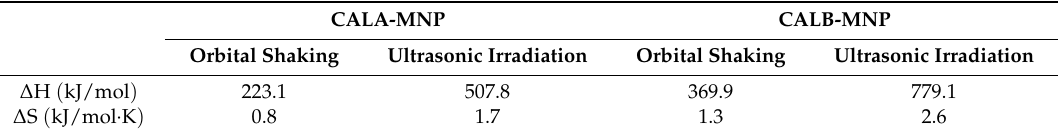
Table 3. Variation of enthalpy and entropy for the synthesis of ethyl butyrate biocatalyzed by CALA-MNP or CALB-MNP under optimal conditions of orbital shaking (150 × rpm ) and ultrasonic irradiation (37 kHz, 300 W). Further details are given in Section